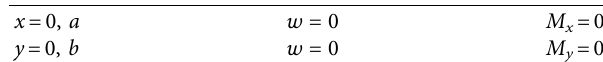
Table 2: Presented boundary conditions.